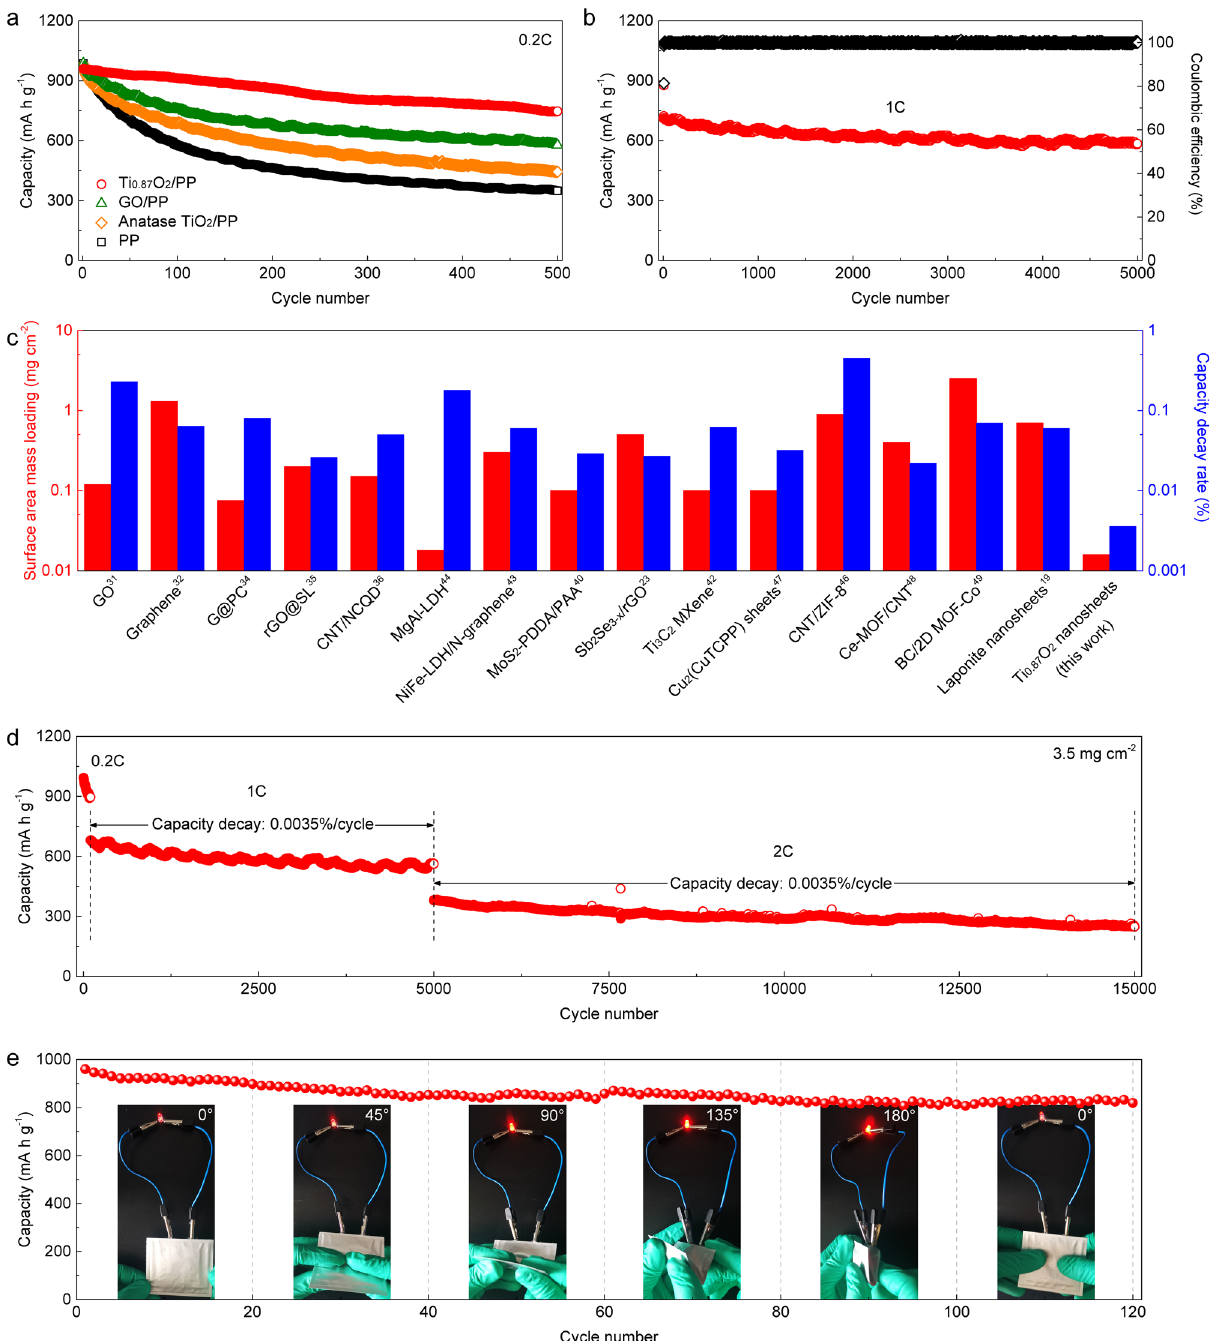
Fig. 6 Li-S cell performance with Ti 0.87 O 2 /PP separators. a Cycling performance with PP, anatase TiO 2 /PP, GO/PP and Ti 0.87 O 2 /PP separators at 0.2 C for 500 cycles. b Long-term cycling stability of a Li-S cell with the Ti 0.87 O 2 /PP separator at 1 C for 5000 cycles. c Comparison of surface area mass loading and cycling performance for Ti 0.87 O 2 nanosheets and some other reported functional layers on commercial separators in Li-S cells. Further details of the selected functional materials are provided in the Supplementary Table S1. d Cycling performance of a Li-S cell with the Ti 0.87 O 2 /PP separator at a sulfur mass loading of 3.5 mg cm − 2 . e Cycling performance of a fl exible Li-S pouch cell with the Ti 0.87 O 2 /PP separator under different bending powder (25nm, Sigma-Aldrich) in water/ethanol solution. The suspension of graphene oxide (GO) nanosheets was prepared from puri fi ed natural graphite by a modi fi ed Hummers ’ method. Fabrication of functional separators . The functional separators were prepared by vacuum fi ltration of stable suspensions on a commercial PP separator (Clegard 2400). Taking Ti 0.87 O 2 /PP functional separator as an example, an aqueous sus- pension of Ti 0.87 O 2 nanosheets (0.05 mL, 4mg mL − 1 ) and poly